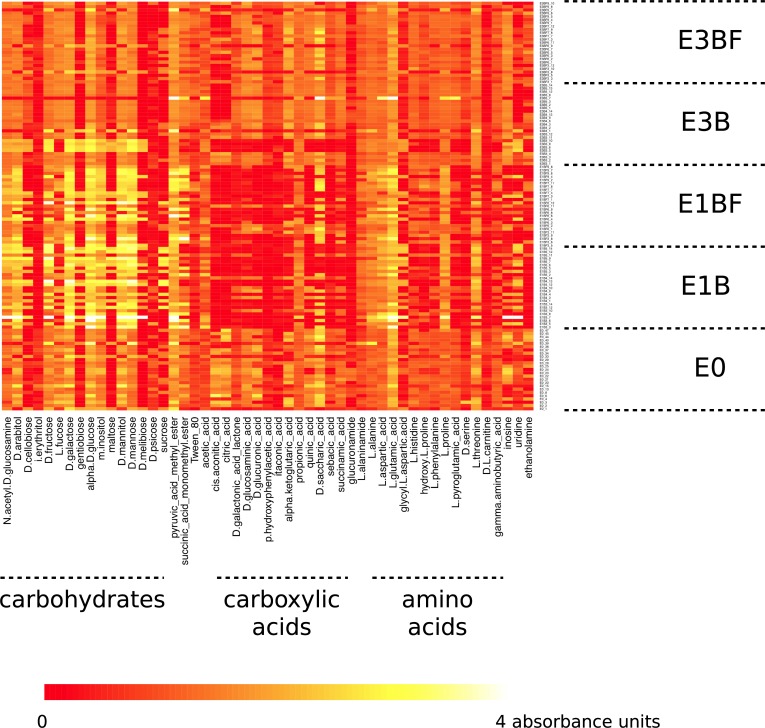
Metabolic profiles of 125 bacterial strains randomly selected in the 5 treatments (E0, E1B, E1BF, E3B, E3BF) (n = 25).The heatmap shows the 51/95 substrates with statistically significant differences between treatments (enrichment step E x presence (BF) or absence (B) of P. chrysosporium) (ANOVA, p<0.05).